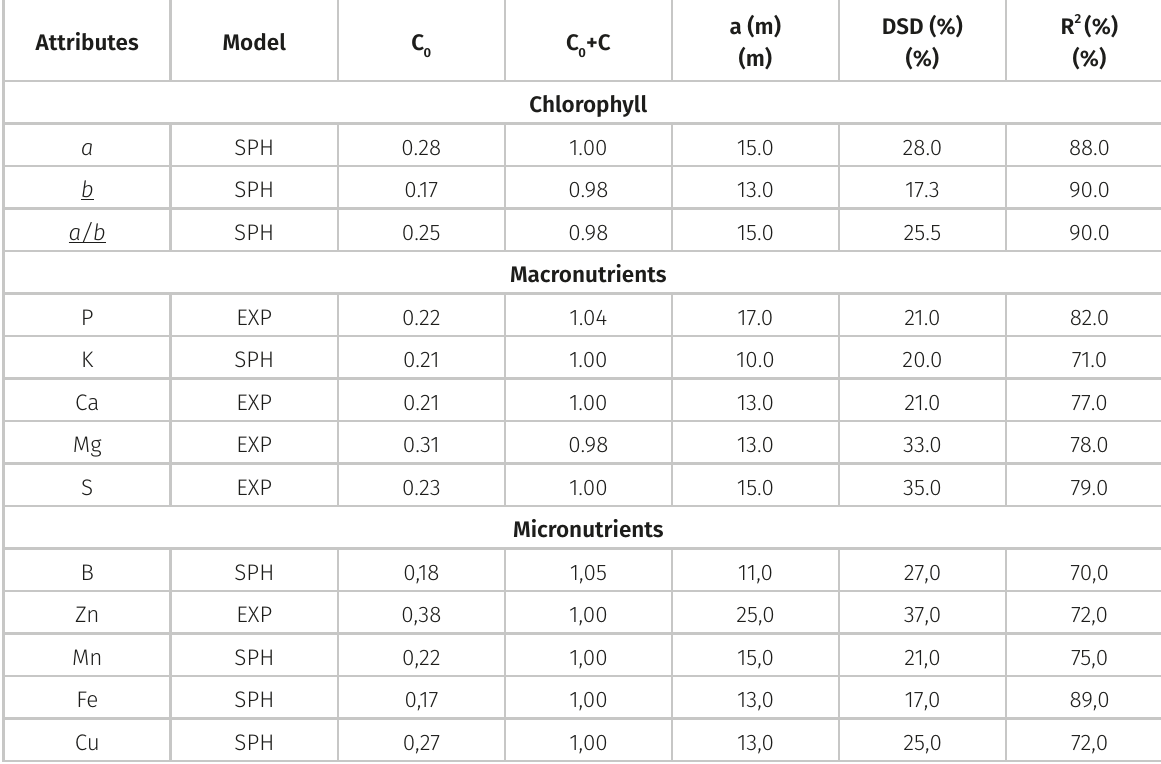
Table IV. Models and parameters of the standardized semivariograms for leaf chlorophyll index